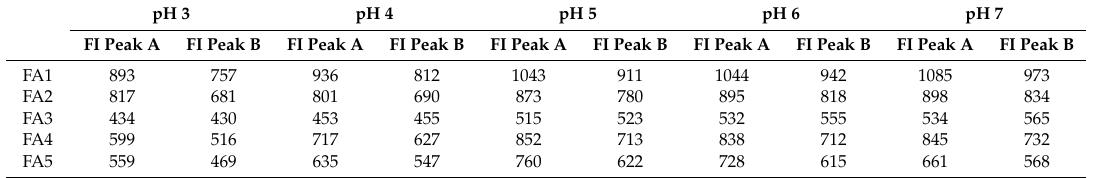
Table 2. Maximum values of fluorescence intensities of FAs regarding A and B peaks at pH